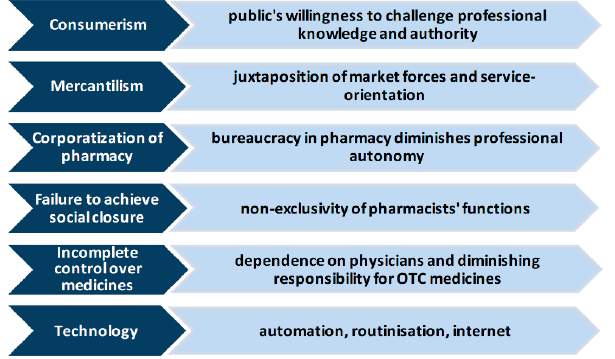
Figure 1. Factors undermining the pharmacy’s professional